Question: Write a single sentence explaining what this figure depicts.
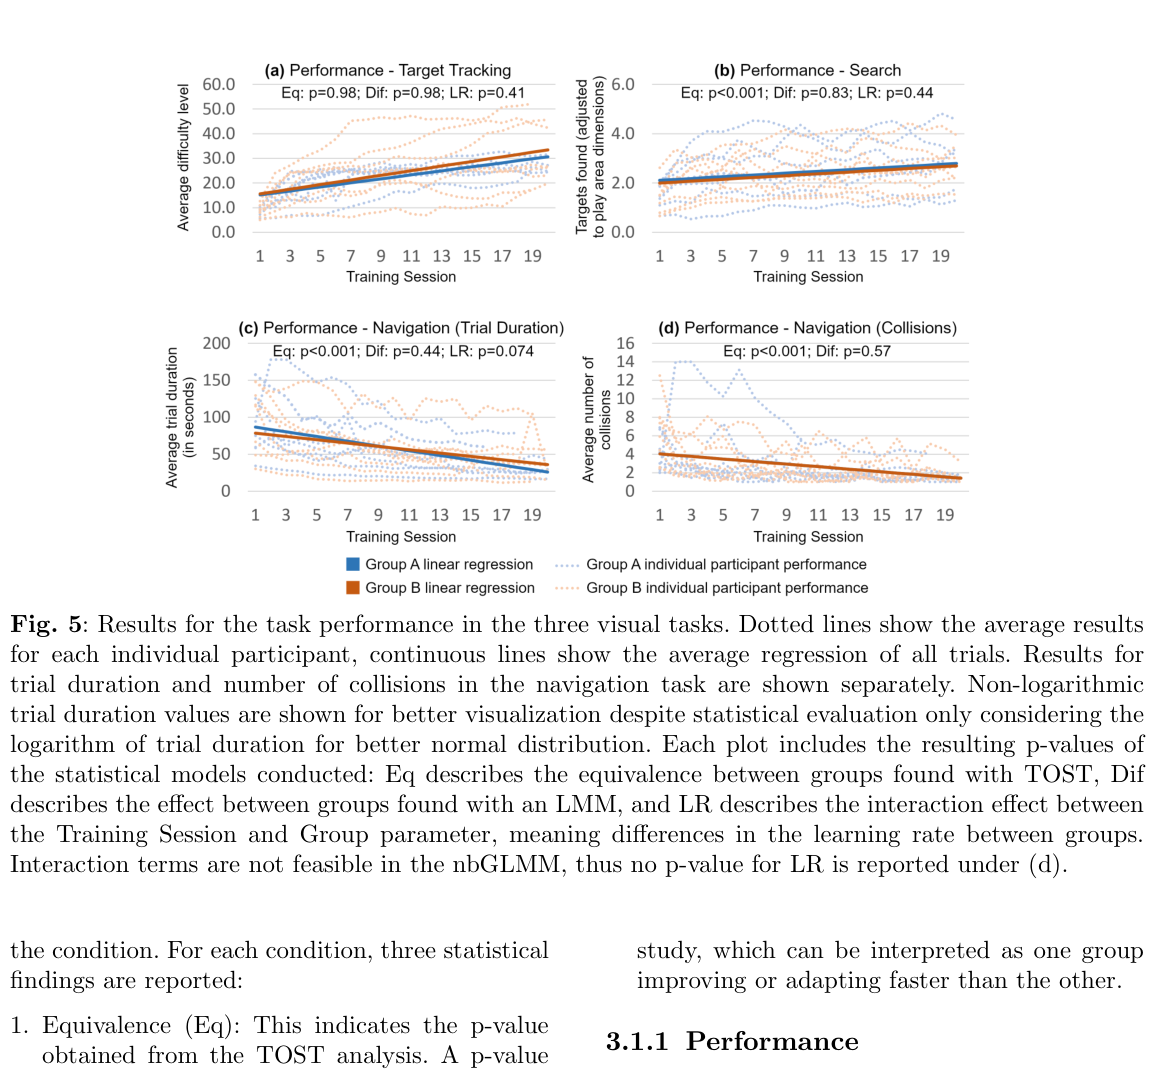
Answer: shows the performance displayed by both groups in the different tasks over the course of training. Raw data of the results is found in the supplementary files (File S1) Both groups show significant improvements in performance over the course of the study in all visual tasks (p < 0.001 for all four conditions). For equivalence, it is found that in the target track- ing task, null hypothesis of statistical difference is not rejected (p = 0.98), indicating that the results of the two groups are not equivalent. For the three other parameters, however, null hypoth- esis of statistical difference is rejected (p < 0.001 for all three parameters), thus the performance of both groups can be assumed equivalent in both the search task and the navigation task. As a sec- ond step, the parameters were analyzed regarding